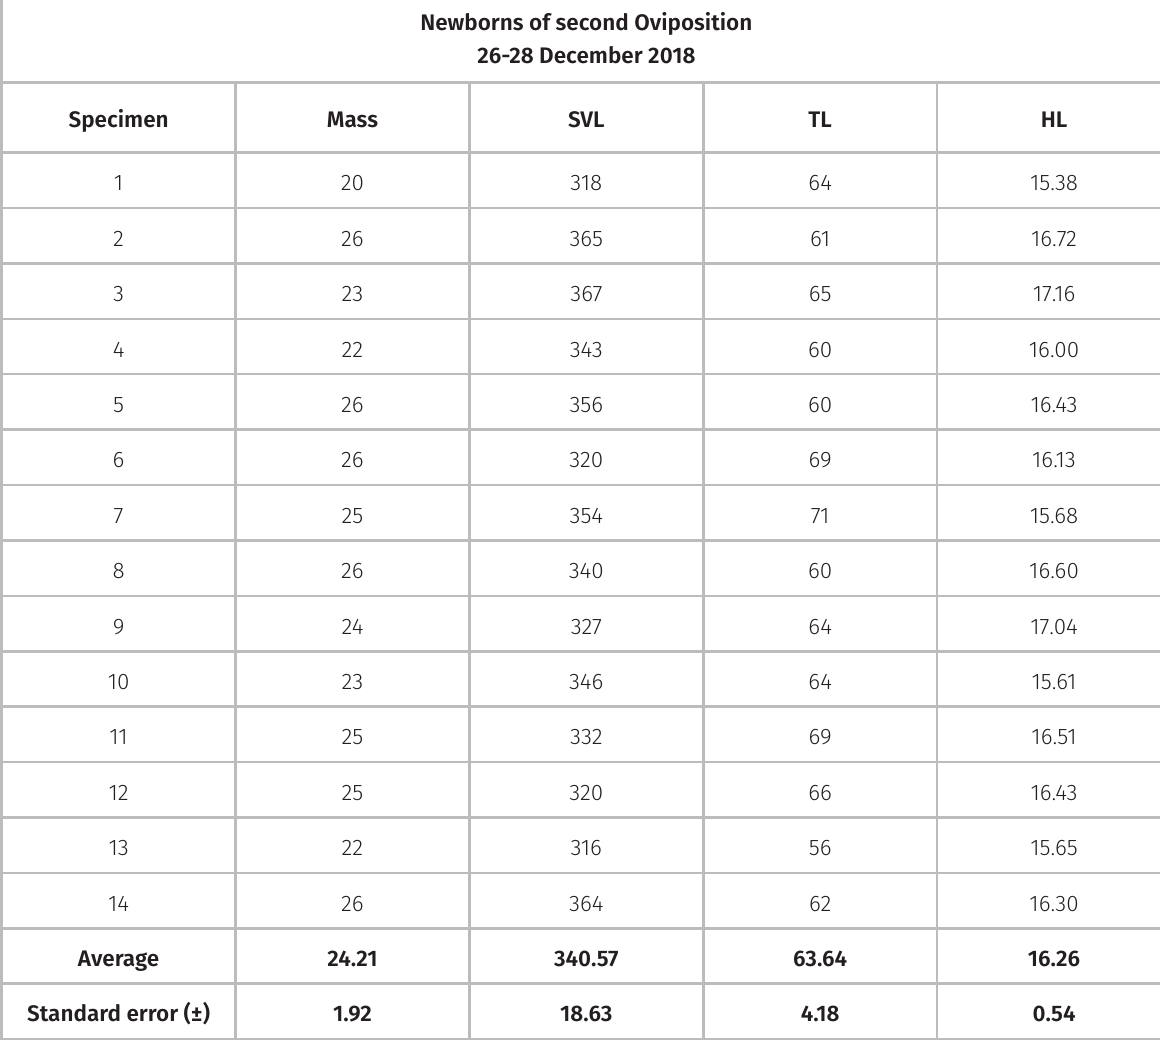
Table II. Measurements collected from the newborns of second oviposition of Boiruna sertaneja from Campina Grande, PB, Brazil. Mass is provided in grams (g) and morphometrical data are provided in milimetres (mm). Snout- vent length = SVL, tail length = TL, head length =